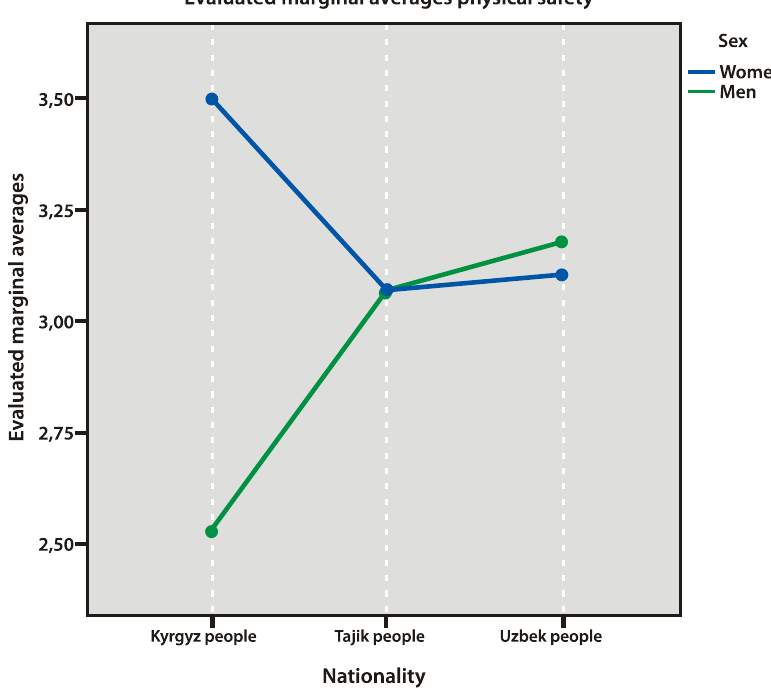
Figure 6. Physical safety factors.